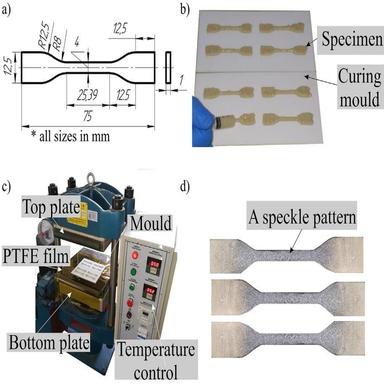
a) Quasi-static tensile test of bulk adhesive specimen; b) DIC as a strain measurement of bulk adhesive specimen.